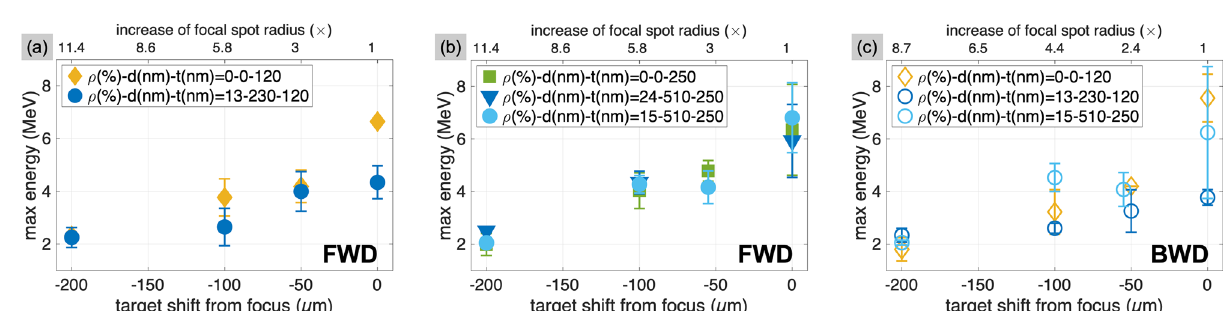
Figure 3. Proton maximum energies measured from regular and perforated foils when increasing the illuminated surface of the target. The increase of the focal spot radius is calculated as z being the shift from focus and z R the Rayleigh length determined in the experiment. ( a ) FWD direction, for targets of 120 nm thickness. ( b ) FWD direction, for targets of 250 nm thickness. ( c ) BWD direction, for a selection of